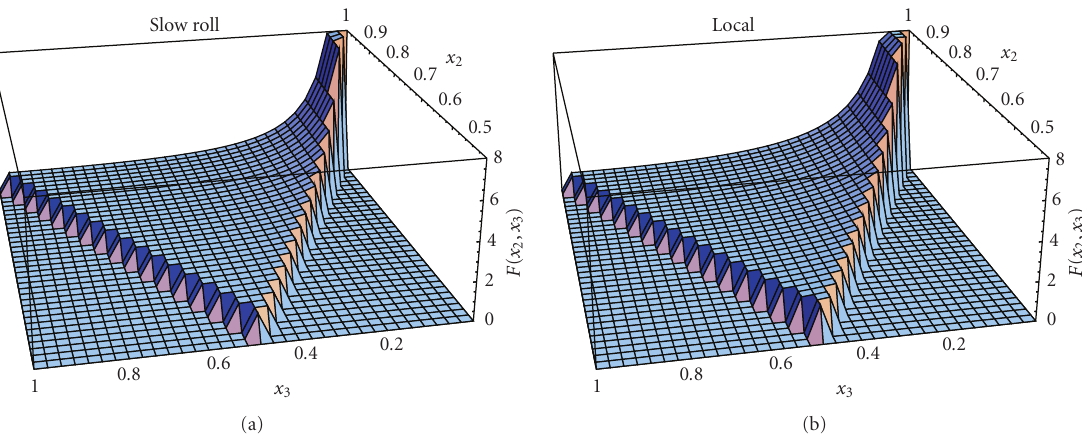
Figure 4: Plot of the function F (1, x 2 , x 3 ) x 2 2 x 2 3 for the Slow-Roll inflation as given by (20) (a) and the local distribution as given by (18) (b). The figures are normalized to have value 1 for equilateral configurations x 2 = x 3 = 1 and set to zero outside the region 1 − x 2 ≤ x 3 ≤ x 2 . Here x 3 ≡ k 3 /k 1 , x 2 ≡ k 2 /k 1 , and (cid:3) = η = 1 / 30. The figures are taken from Babich et al. 2004 [86].